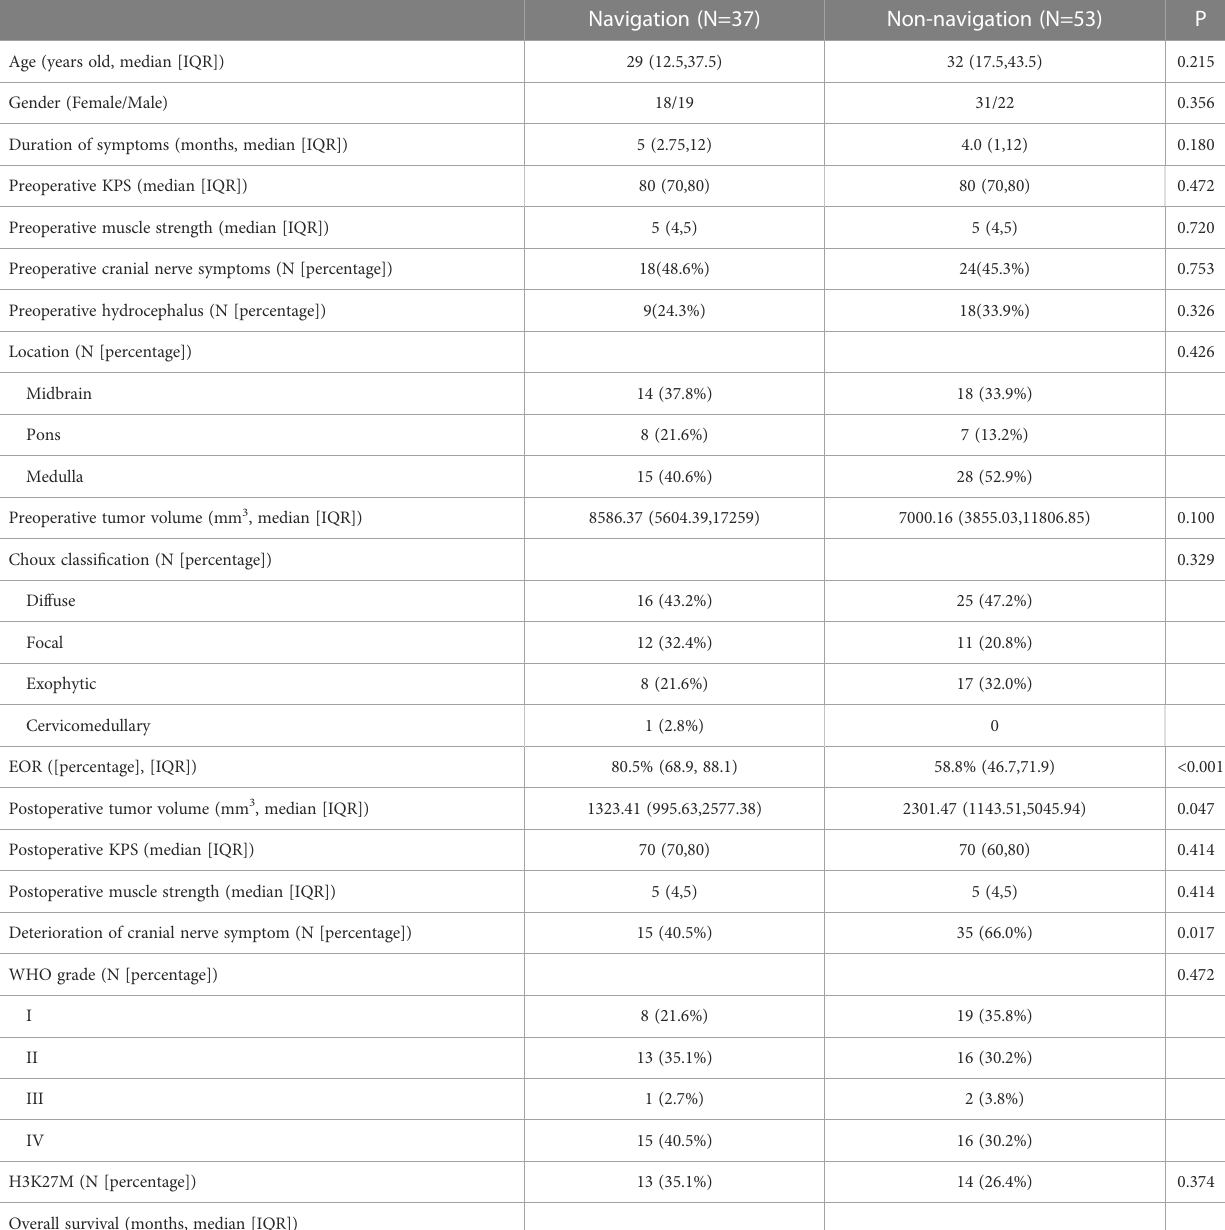
TABLE 1 The summary of included patients